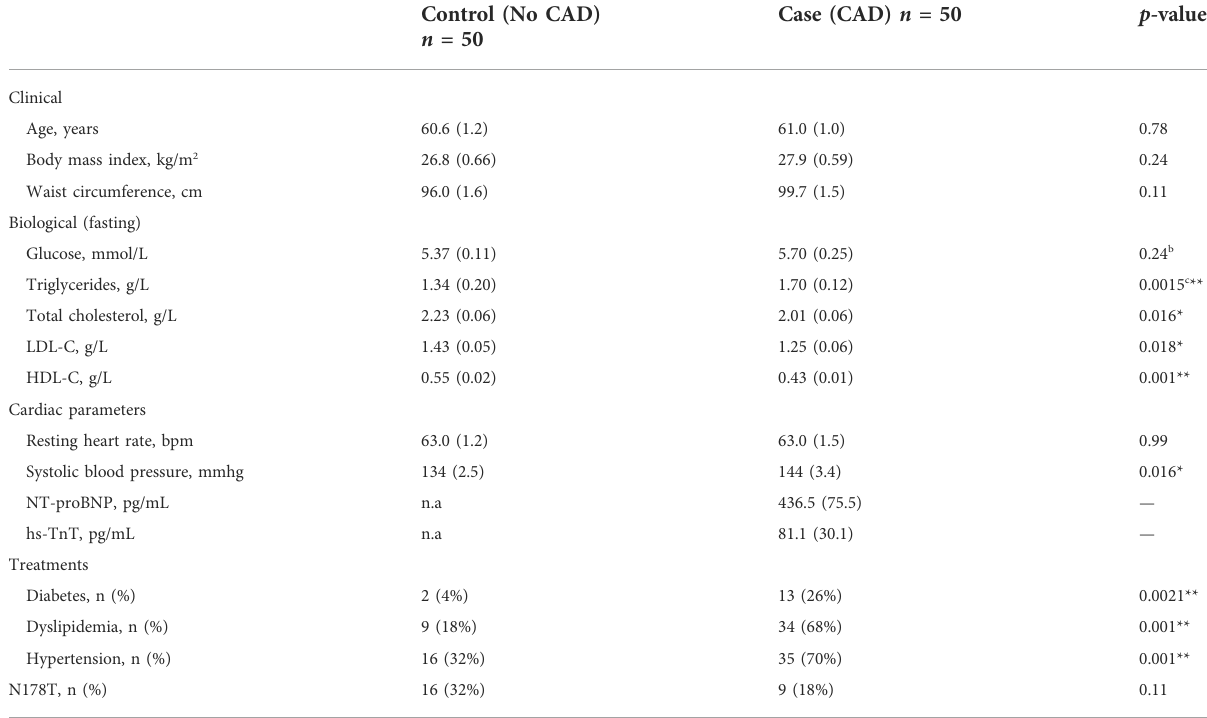
TABLE 3 Baseline characteristics of the population from the GENES case-control study, according to status for